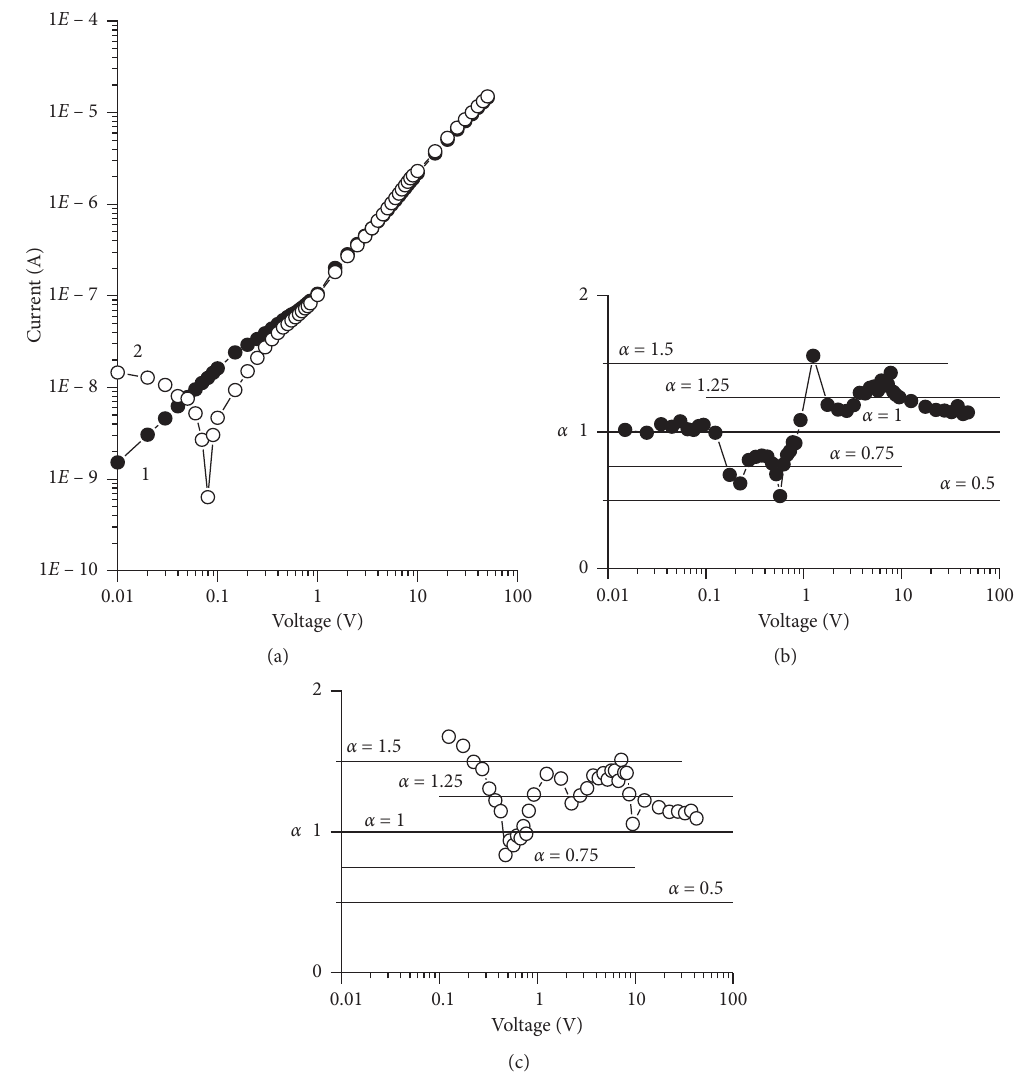
Figure 6: I-V characteristics (a) and their dimensionless sensitivity (b, c) of the TiO lumination